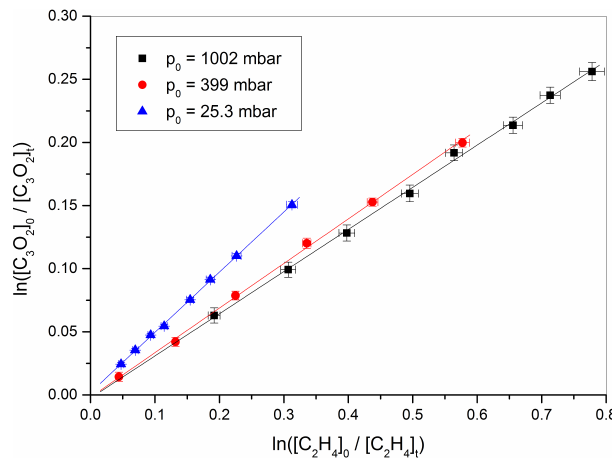
Figure 6. Depletion factors for C 3 O 2 versus C 2 H 4 during reaction of both traces gases with OH at three different pressures. Error bars are 2 σ as returned by the least-squares fitting routine. The slope at each pressure yields the relative-rate constant ratio k 4 /k 5